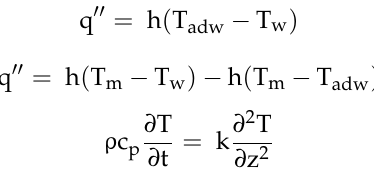
Figure 5. Pressure coefficient via CFD and experiment.